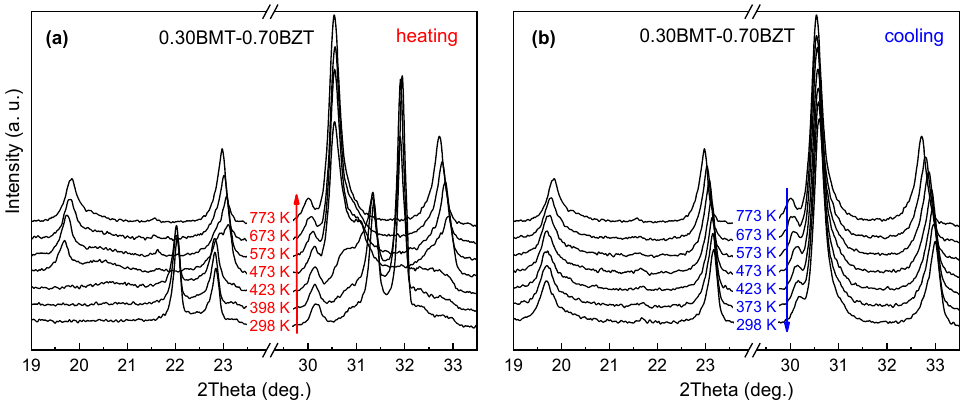
Figure 2. The most representative ranges of the XRD patterns of the as-prepared (1- x )BMT– x BZT sample ( x = 0.70) at the first thermal cycle: ( a ) upon heating to 773 K and ( b ) upon cooling to room temperature. The structural phases at room temperature before and after the annealing are the orthorhombic Pnnm and the tetragonal P 4 mm , respectively.